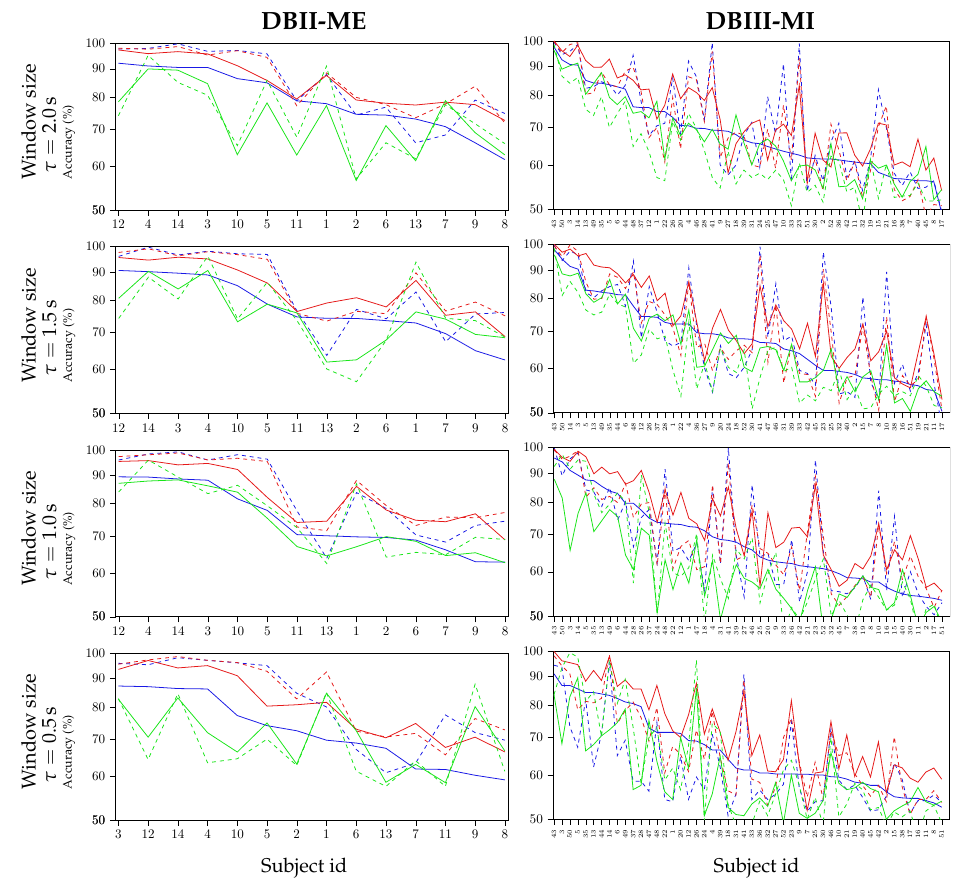
Figure 3. Individual classifier performance at different window lengths using FC: PLV ( ), CFF ( ), and GFC ( ). The accuracy assessments performed without CSP are outlined with a continuous line, after CSP filtering—with a dashed line. The subjects are displayed on the horizontal axis in decreasing order of their CCF-based